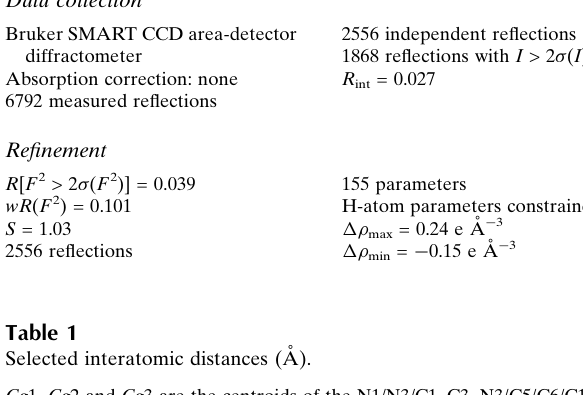
Selected interatomic distances (A˚ ).